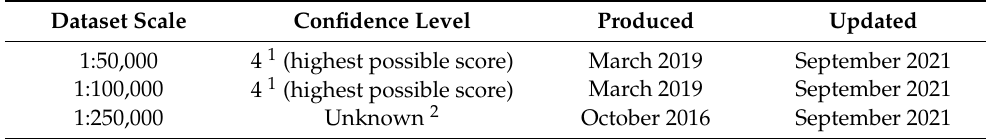
Table 6. Seabed substrate dataset